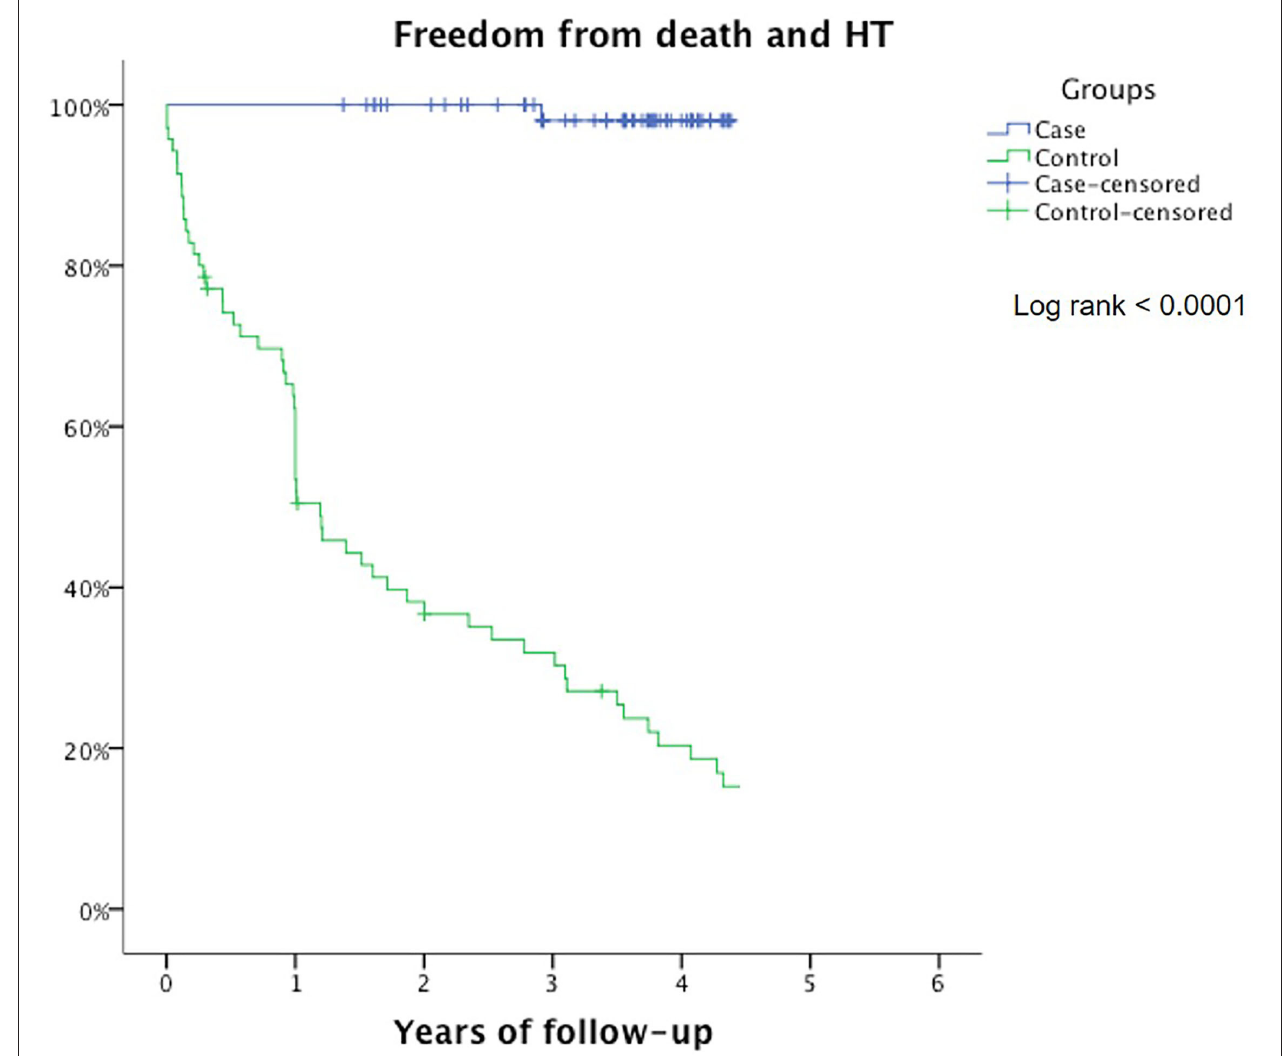
FIGURE 1 | Freedom from death/heart transplant represented by Kaplan–Meier curves in carvedilol group (blue) and control group